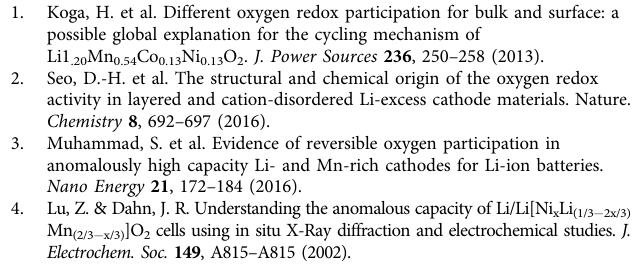
Fig. 5 Redox potentials. a d electron con fi gurations for different oxidation states of Ru and Ir. The spin down electron on Ir 5 + is at a higher energy and hence oxidised at a lower voltage than removal of a spin up electron from the stable d 3 con fi guration of Ru 5 + . Since oxidation of Ir 5 + occurs before O 2 − /O 2 and Ru 5 + does not, we place O 2 − /O 2 between the two redox couples in the fi gure ( b ). The values of the redox couples shown in black in ( b ) were obtained from dQ/dV analysis extracted from the data in Fig.